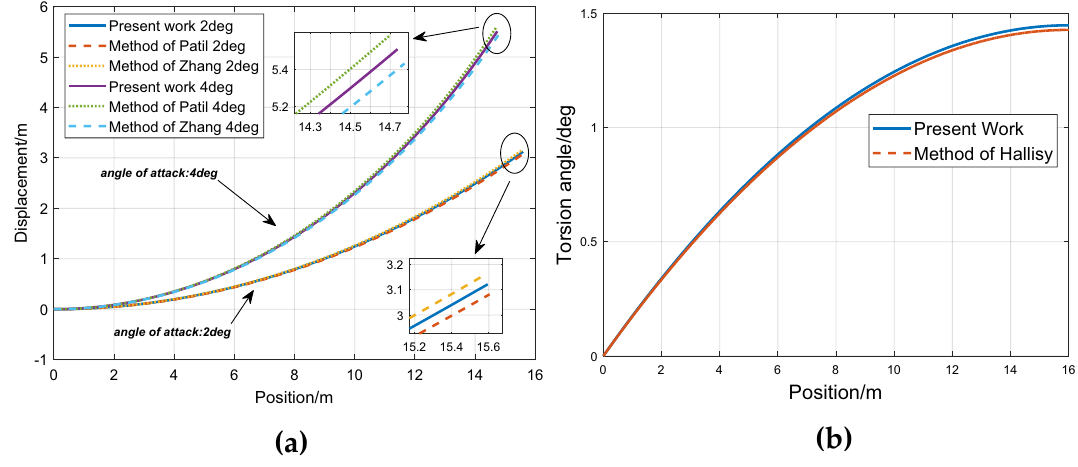
Figure 4. Model validation comparing with the literatures: ( a ) Bending displacement compare results; ( b ) Torsional displacement compare